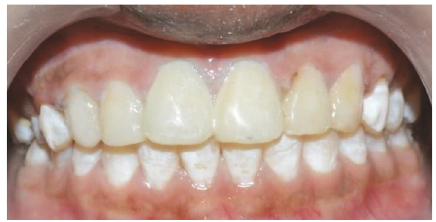
Figure 3: 2-year follow-up.